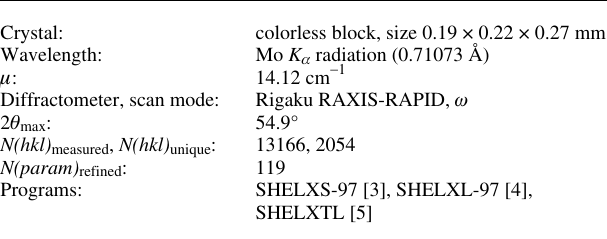
Table 1. Data collection and handling.